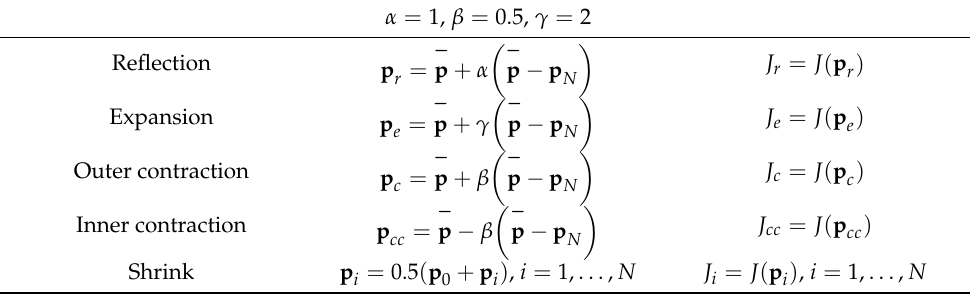
Table 1. Various vertices that may be tried during the iteration of the N–M simplex method.